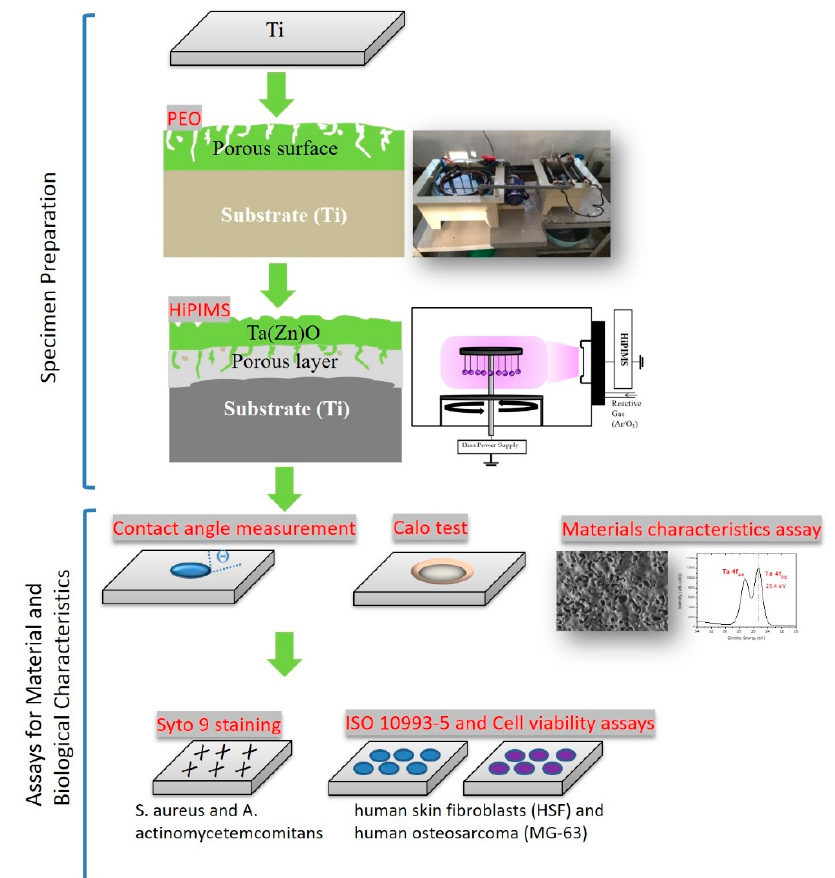
Figure 1. Schematic illustration of the technical processing route.